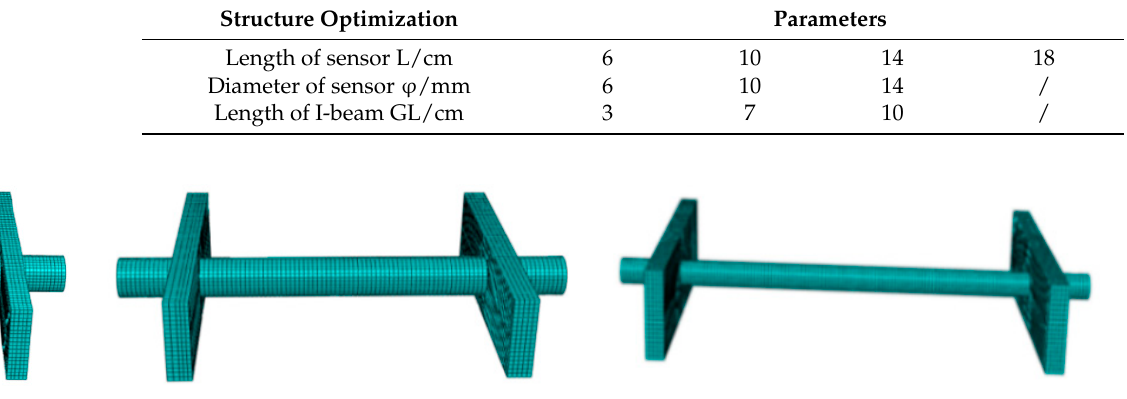
Figure 9. Schematic diagram of structural optimization modeling for the I-sensor.